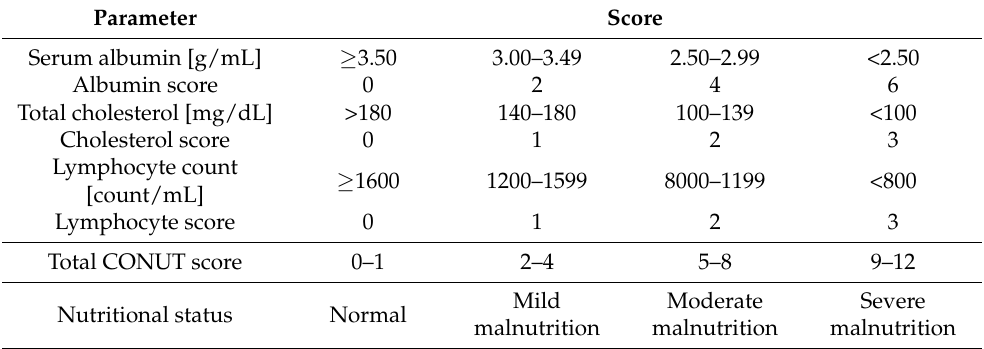
Table 2. The Controlling Nutritional Status (CONUT)